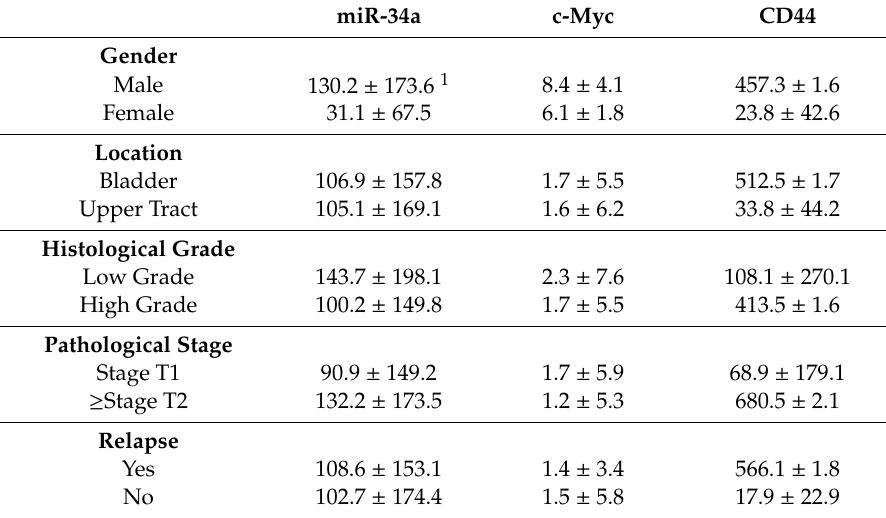
Table 1. Correlation between the expression of miR-34a , c-Myc , CD44 , and clinical-pathological data in 55 UC samples.